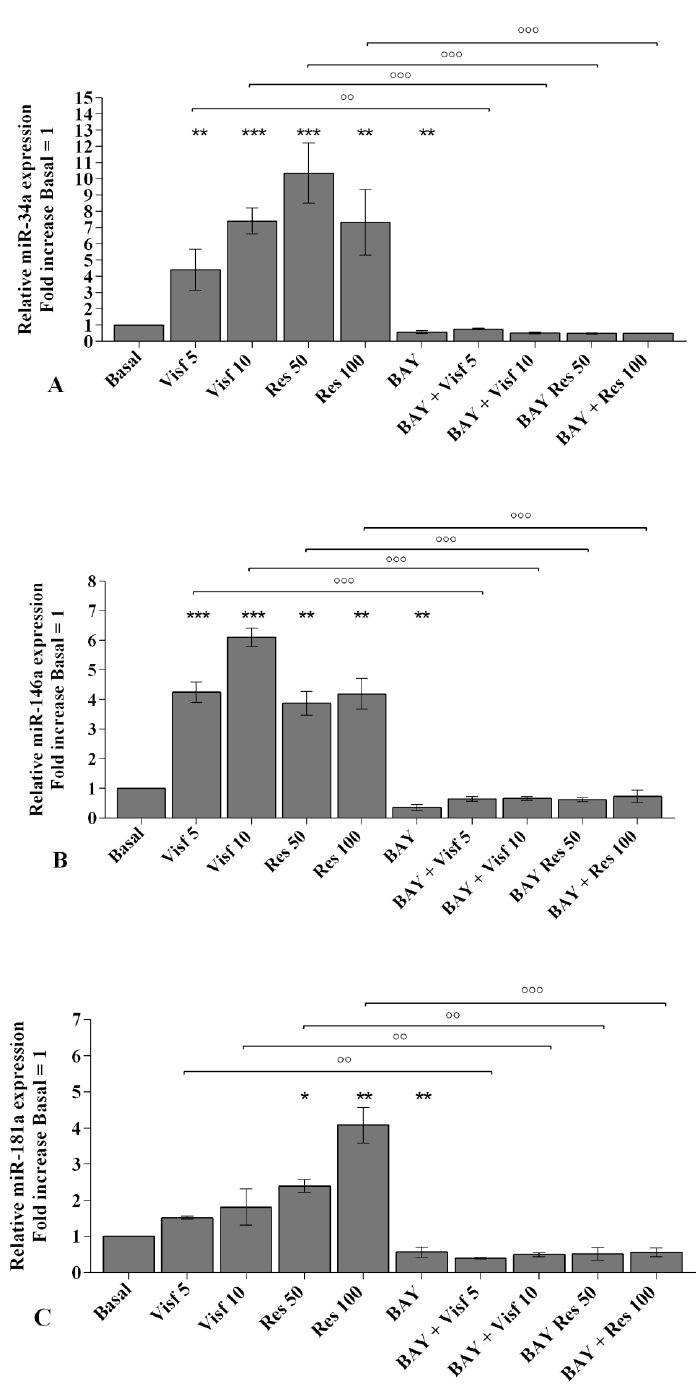
Figure 13. Expression levels of miR-34a ( A ), miR-146a ( B ), and miR-181a ( C ) by real-time PCR. Human osteoarthritic (OA) synovial fibroblasts were evaluated at basal condition, after 2 h pre-incubation with a specific nuclear factor (NF)- κ B inhibitor (BAY 11-7082, IKK α / β , 1 µ M) and after 24 h of stimulus with visfatin (5 and 10 µ g / mL) and resistin (50 and 100 ng / mL). The gene expression was referenced to the ratio of the value of interest and the value of basal condition (basal, cells without treatment) reported equal to 1. Data were expressed as mean ± SD of triplicate values. * p < 0.05, ** p < 0.01, *** p < 0.001 versus basal condition. ◦◦ p < 0.01, ◦◦◦ p < 0.001 versus BAY. BAY = BAY 11-7082, Visf = visfatin, Res =